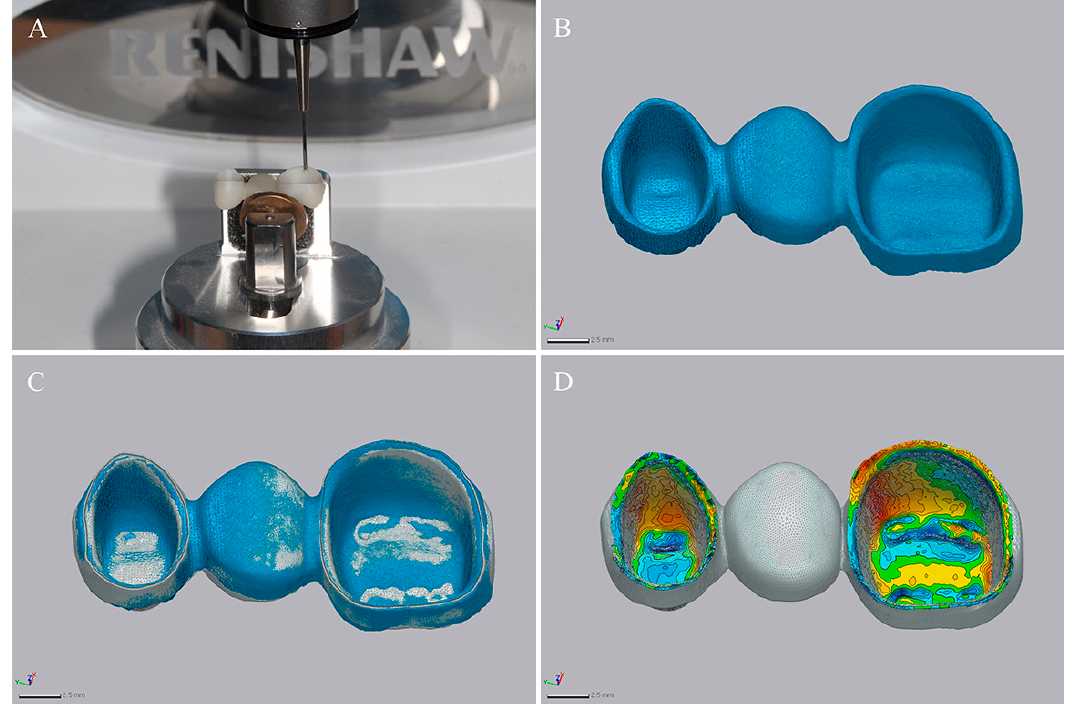
Figure 4. Process for the 3-dimensional analysis of trueness. ( A ) Touch-probe scanning. ( B ) Inner surface scan of 3-unit fixed dental prosthesis. ( C ) Superimposition. ( D ) Color difference map.